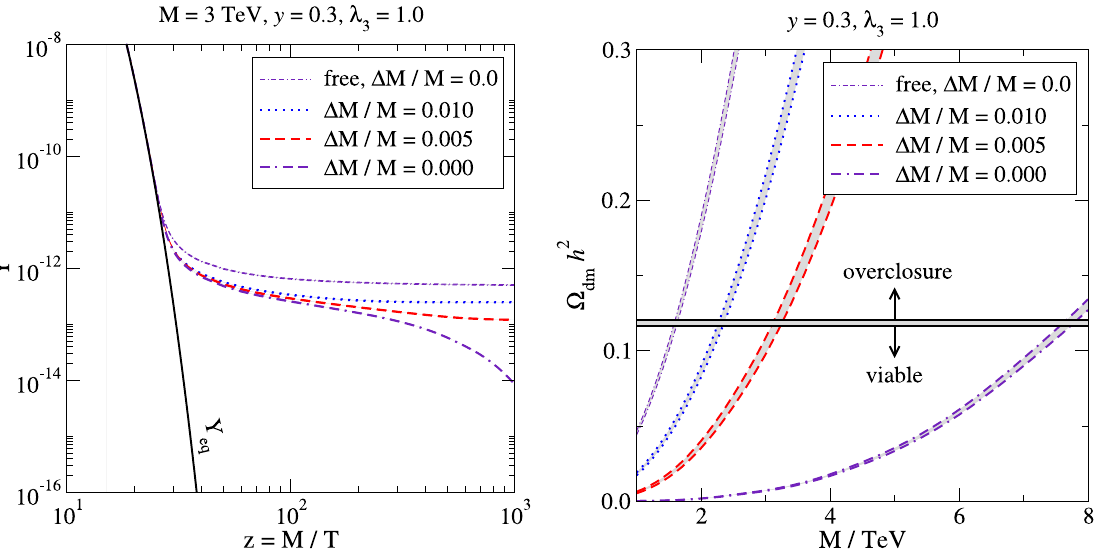
Figure 3 . Left: solutions of eq. (5.1) for M = 3 TeV and selected values of ∆ M/M . The quark Yukawa coupling h is either 0 . 0 (upper edges of bands) or 1 . 0 (lower edges). If ∆ M/M is too small, dark matter may convert to coloured scalars and get efficiently annihilated; this is only partly visible, because we have stopped the integration at z = 10 3 . Right: the dark matter abundance final at z = 10 3 . The horizontal band shows the observed value 0 . 1186(20) final